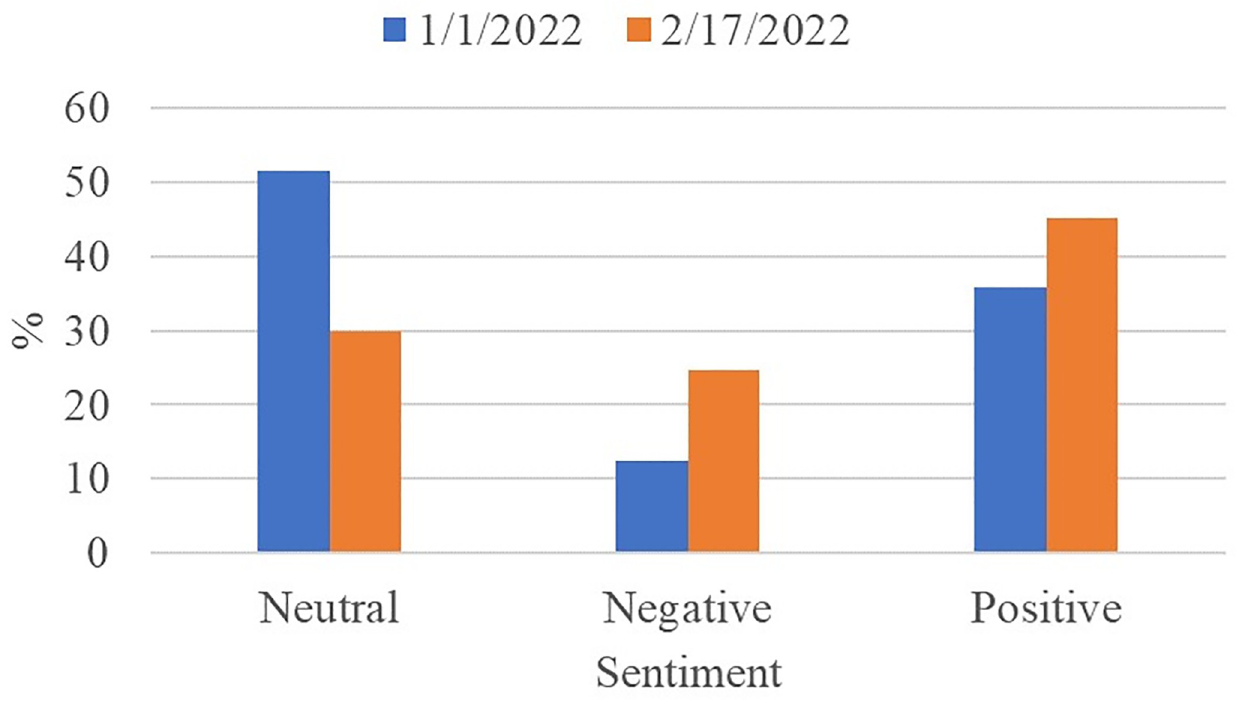
Fig 12. Comparison of positive, negative and neutral tweets on 1st January and 17 February 2022.